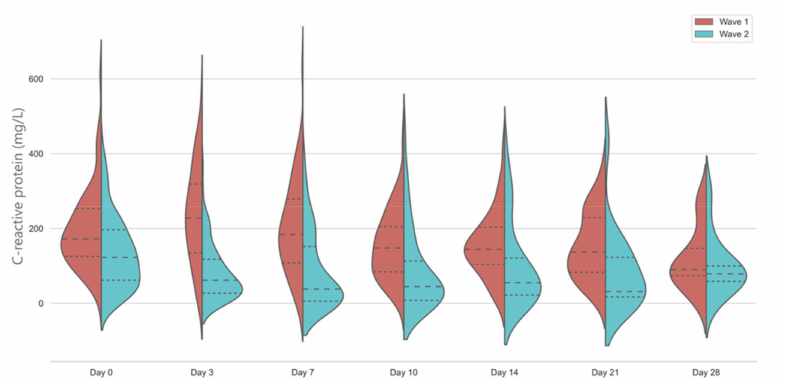
Figure 2. Temporal changes in C-reactive protein levels in the first and second wave. Violin plots represent distribution of data. Dashed lines show medians and interquartile ranges. The general linear model indicates significant differences between days in wave 1 and between groups, p <